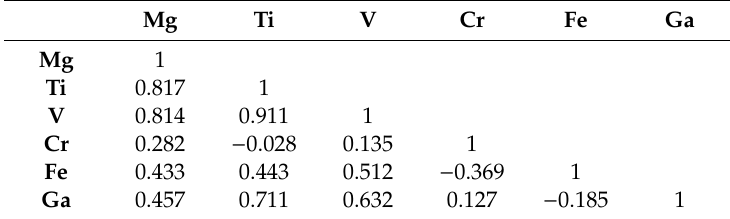
Table 3. Correlation table for trace elements of Thai / Cambodian